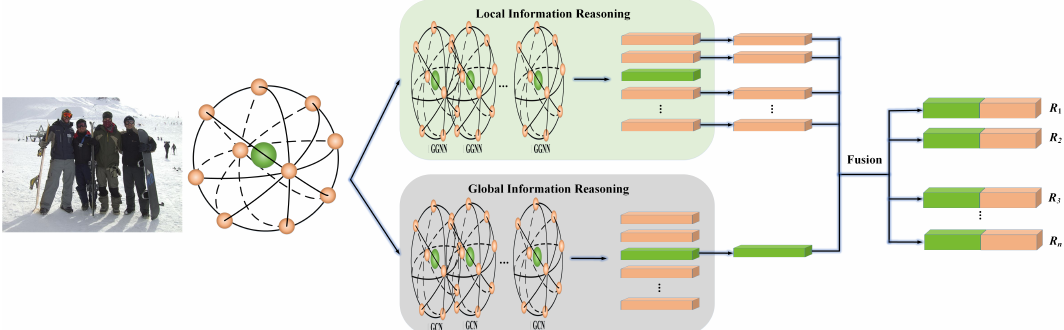
Figure 1. Overall architecture of our proposed model. We first treat the social relations and the scene feature as nodes to construct a relation-scene graph, where one orange node represents a pair of people and the green node represents the scene feature. Then the constructed graph is reasoned by local–global information reasoning modules to obtain the local information and the global information. Finally, they are concatenated for social relation classification.